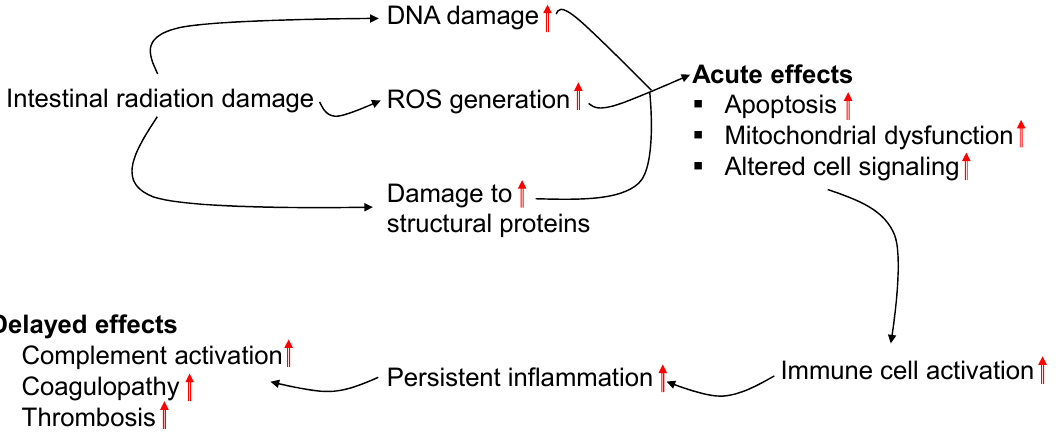
Figure 4. Summary of events and resulting pathological condition because of acute and delayed effects of intestinal radiation injury.